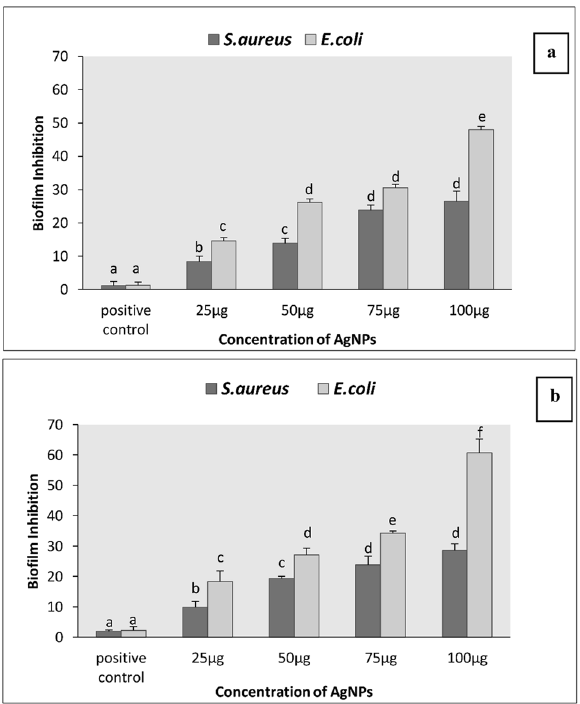
Figure 5. Determination of the rate of antibiofilm inhibition by biosynthesized AgNPs (a) AgNPs CONTROL, (b) AgNPs SMF . The results are expressed as means + /– SD of triplicate measurements. Significant differences are indicated by different letters (b, c, d, e, f) vs. positive control (p <